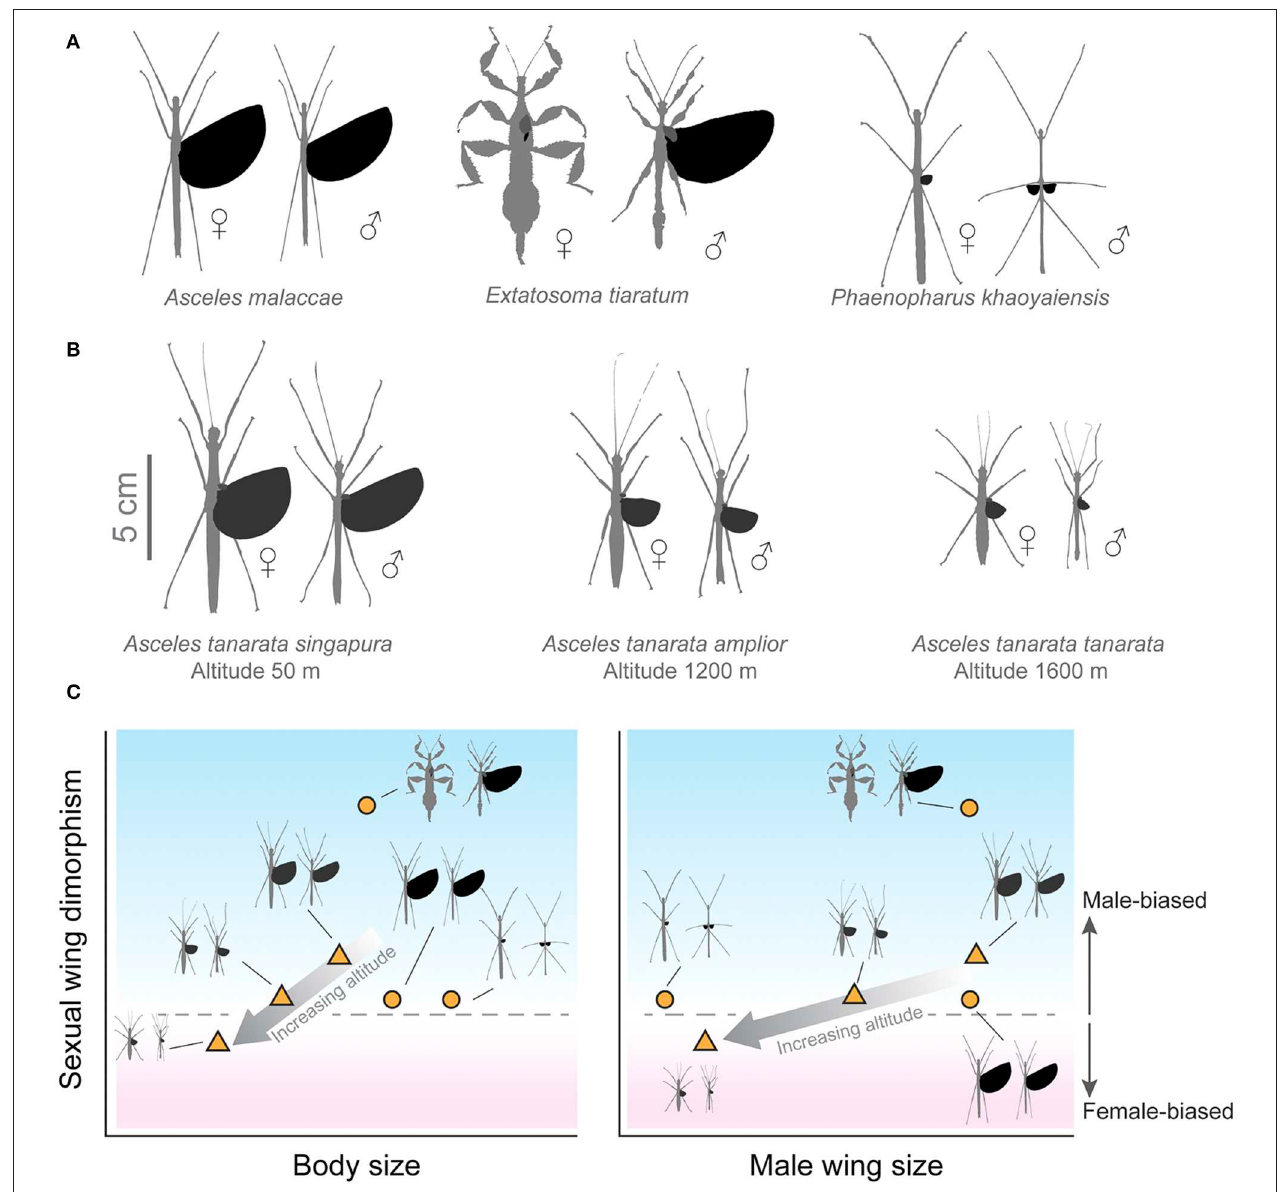
FIGURE 2 | Sexual wing dimorphism (SWD) in stick insects. (A) Representative combinations of variable relative wing size and SWD: (1) low SWD with long wings in both sexes, (2) extreme SWD with long wings in males only, and (3) low SWD with short wings in both sexes. (B) Variation in wing and body sizes for the Asceles tanarata species group, for which SWD transitions from male- to female-biased with increasing altitude. (C) Schematic demonstration of variations in SWD with respect to body size and male wing size; numbers denoting taxa depicted in (A,B ). The gray arrow indicates elevational changes with increasing altitude in the A. tanarata